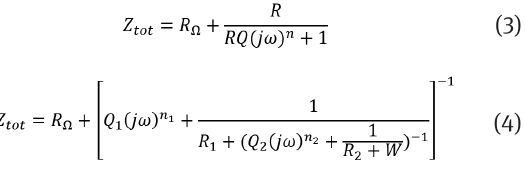
Table 4: Amount of dissolved iron in 0.1 mol L -1 NaCl solution at E containing SM and PF of Satureja montana L. obtained by the AAS